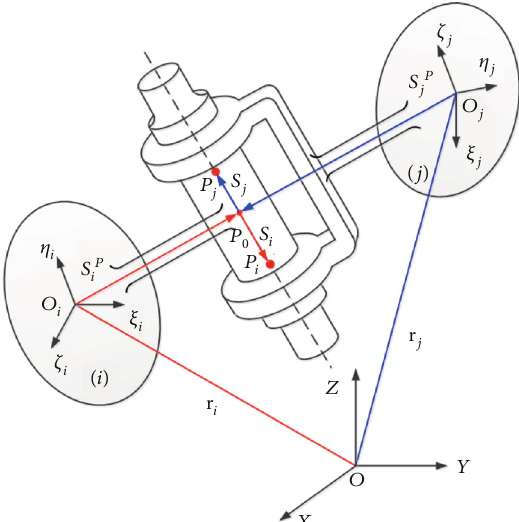
Figure 1: 3D revolute joint connecting bodies i and j